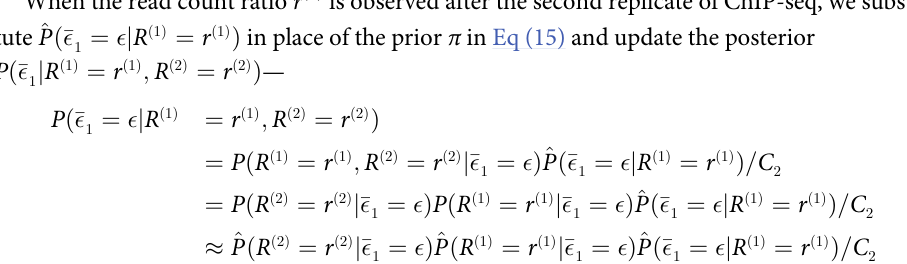
S1 Fig. Impact of power-law based genome-wide heterogeneity in extraction and PCR efficiency on motif inference and ChIP-seq fidelity. (A) Impact of heterogeneity in mean amplification ratio (left panel) and extraction efficiency (right panel) on motif inference. The heterogeneity follows a power law truncated between 0 and 1. The error bars are the standard deviation in the mean K-L distance computed after PWM was estimated in 10 replicates of ChIP-seq for each mean and coefficient of variation. (B) Impact of heterogeneity in mean amplification ratio (left panel) and extraction efficiency (right panel) on fidelity. The fidelity is calculated for all regions (orange), the top 25th percentile (blue) and bottom 25th percentile (black) of read count ratios. The error bars are the standard deviation in the estimate of fidel- ity, which are computed from 10 replicates of simulation for a given mean and coefficient of variation. S2 Fig. Impact of chemical potential (TF concentration) on motif inference and fidelity. (A) Left panel: Read count ratios from three different ChIP-seq simulations run